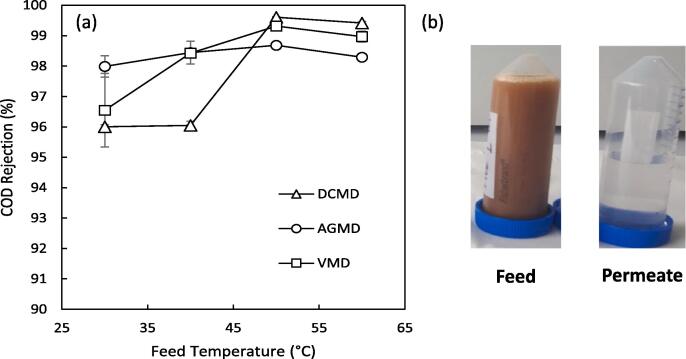
(a) Comparison of COD rejection at different temperatures by AGMD, DCMD and VMD (b) photos showing representative feed and permeate quality. (Tp,i = 20 °C for DCMD and AGMD, 0.1 μm PTFE membrane; 1.8 wt% (Faeces/Urine) pH: ~7–9, COD: 7–15 g L–1, NH4-N: 0.1–1.3 g L–1, E. coli: ~4–8 log10 CFU mL−1).